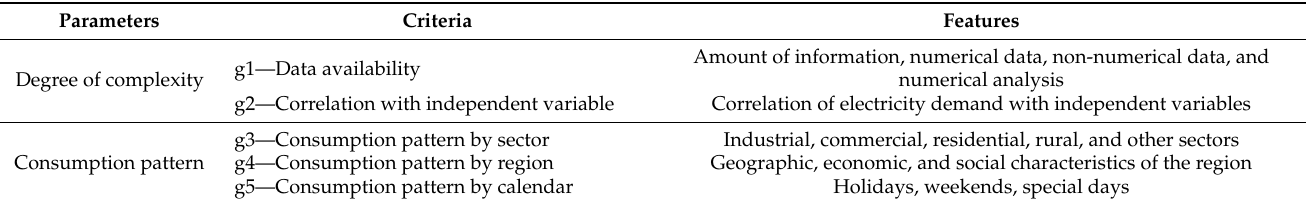
Table 3. Criteria listed in the